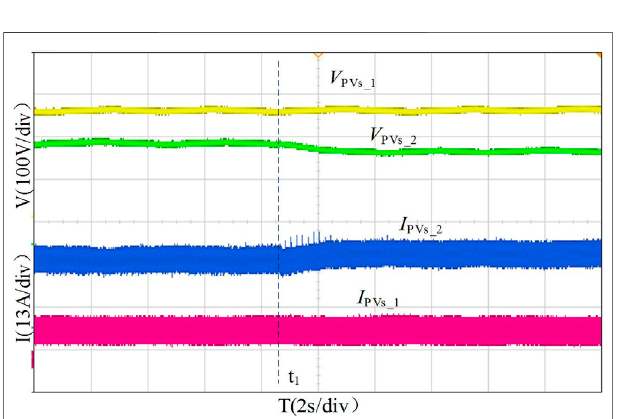
FIGURE 15 | Identi fi cation control test waveforms at the starting stage.